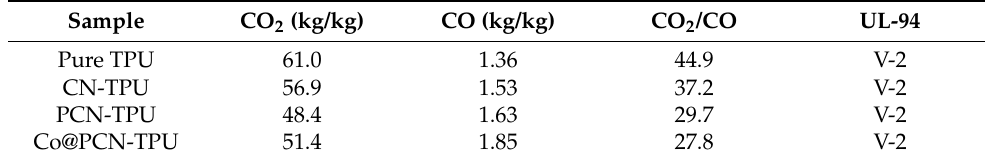
Table 5. CO 2 and CO data, and UL-94 test results of TPU and its